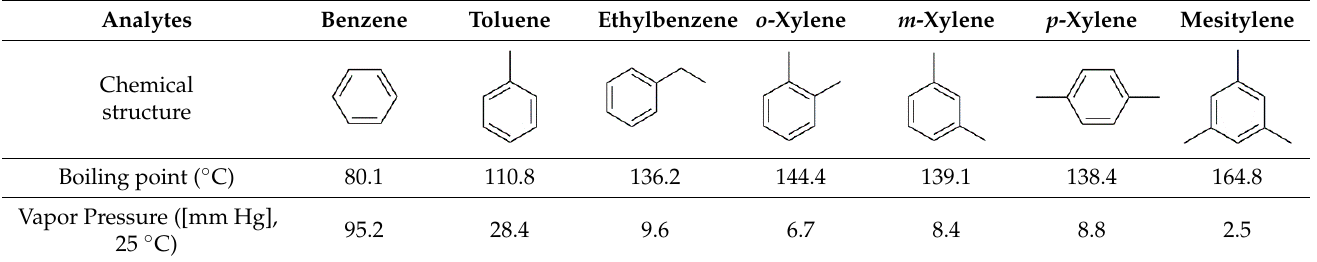
Table 1. Chemical structures and important physical parameters of BTEX and mesitylene [24]. Analytes